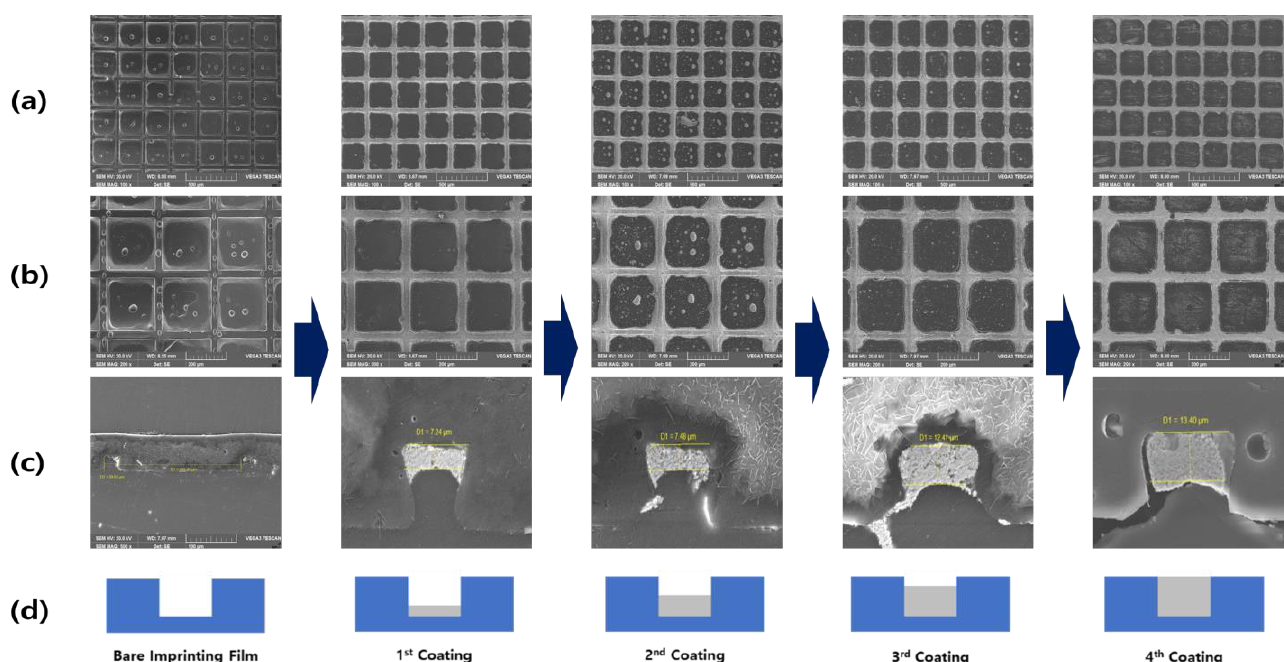
Figure 7. Change in shape according to pattern molding via coating of the conductive binder. ( a ) Top view with ×100. ( b ) Top view with ×200. ( c ) Sectional view ×3000. ( d ) Filling schematic diagram by coating step.